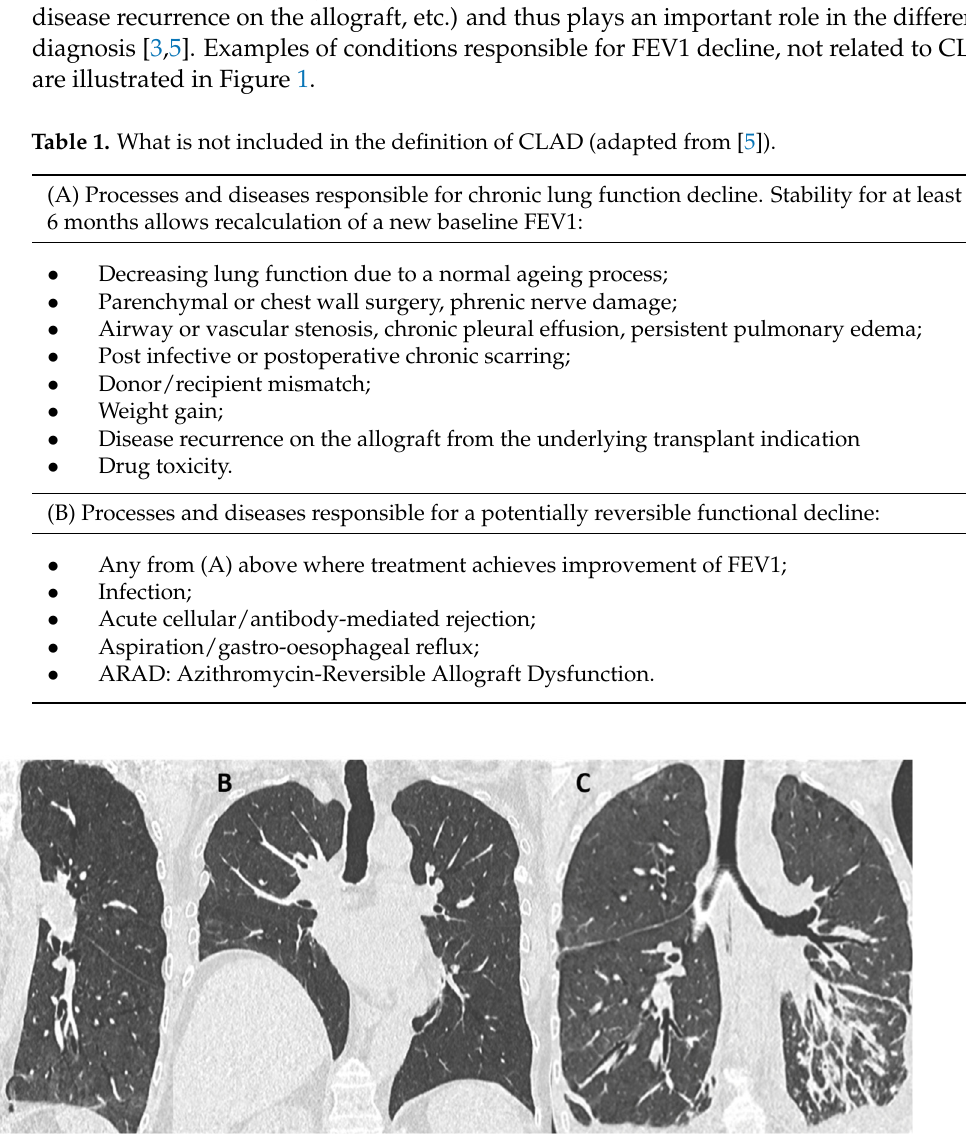
Figure 1. Examples of non ‐ CLAD conditions. ( A ) Right lower lobe bronchial stenosis responsible for obstructive changes on PFT; ( B ) post ‐ surgical right phrenic nerve damage responsible for restrictive changes; ( C ) development of Kaposi’s sarcoma on the lung graft responsible for mixed obstructive and restrictive changes. Table 1. What is not included in the definition of CLAD (adapted from [5]).